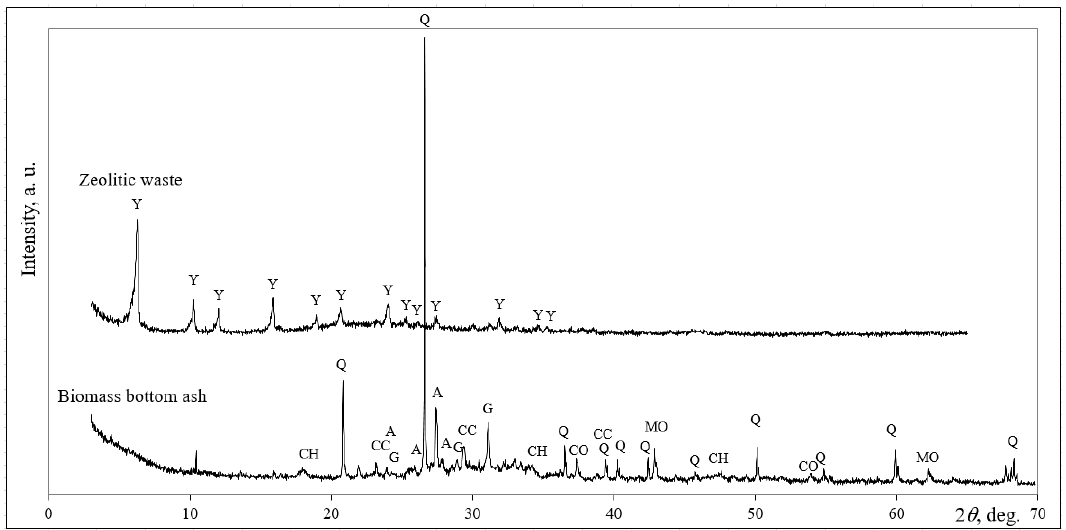
Figure 6. Mineral composition of initial aluminosilicate materials. Notes: Q—quartz SiO 2 (77–1070), CH—calcium hydroxide Ca(OH) 2 (84–1271), CC—calcium carbonate Ca(CO) 3 (72–1652), A— anorthoclase (Na,K)(Si 3 Al)O 8 (75-1631), G—gehlenite Ca 2 Al(AlSiO 7 ) (79-2421), CO—calcium oxide CaO (4–777), MO—magnesium oxide MgO (78-430) and Y—aluminum silicon hydrate